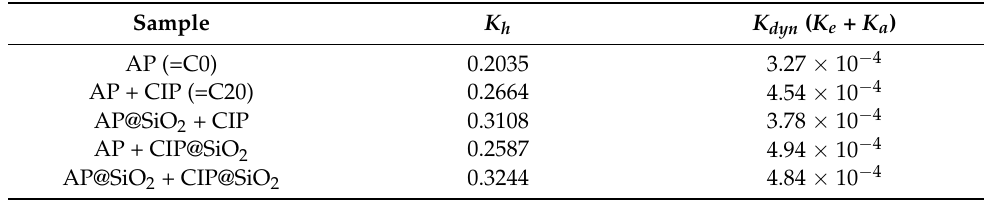
Table 4. Derived hysteresis loss constant ( K h ) and dynamic loss constant ( K dyn = K e + K a ) of insu- lated